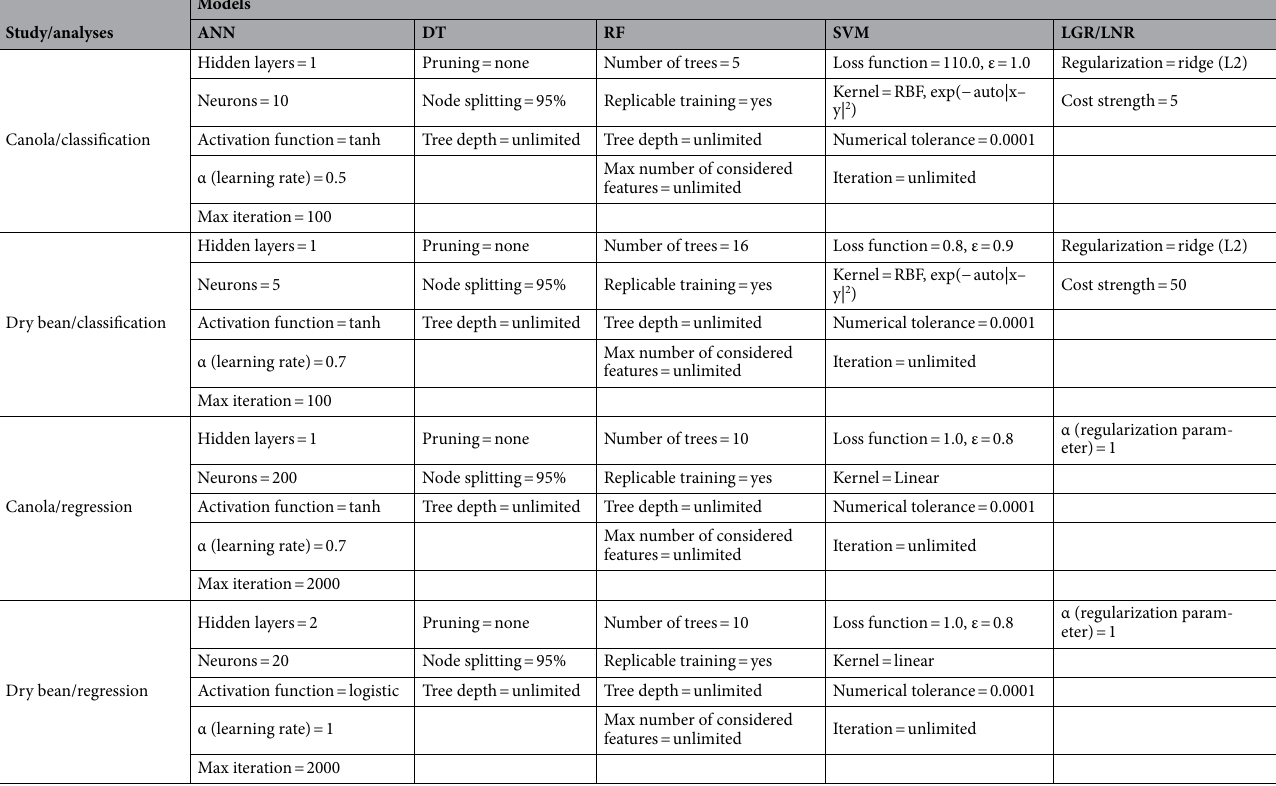
Table 6. Parameter estimates of artificial neural networks (ANN), decision trees (DT), random forest (RF), support-vector machine (SVM), logistic regression (LGR), and linear regression (LNR) machine-learning models used in classification and regression analyses. LGR was used in classification and LNR in regression